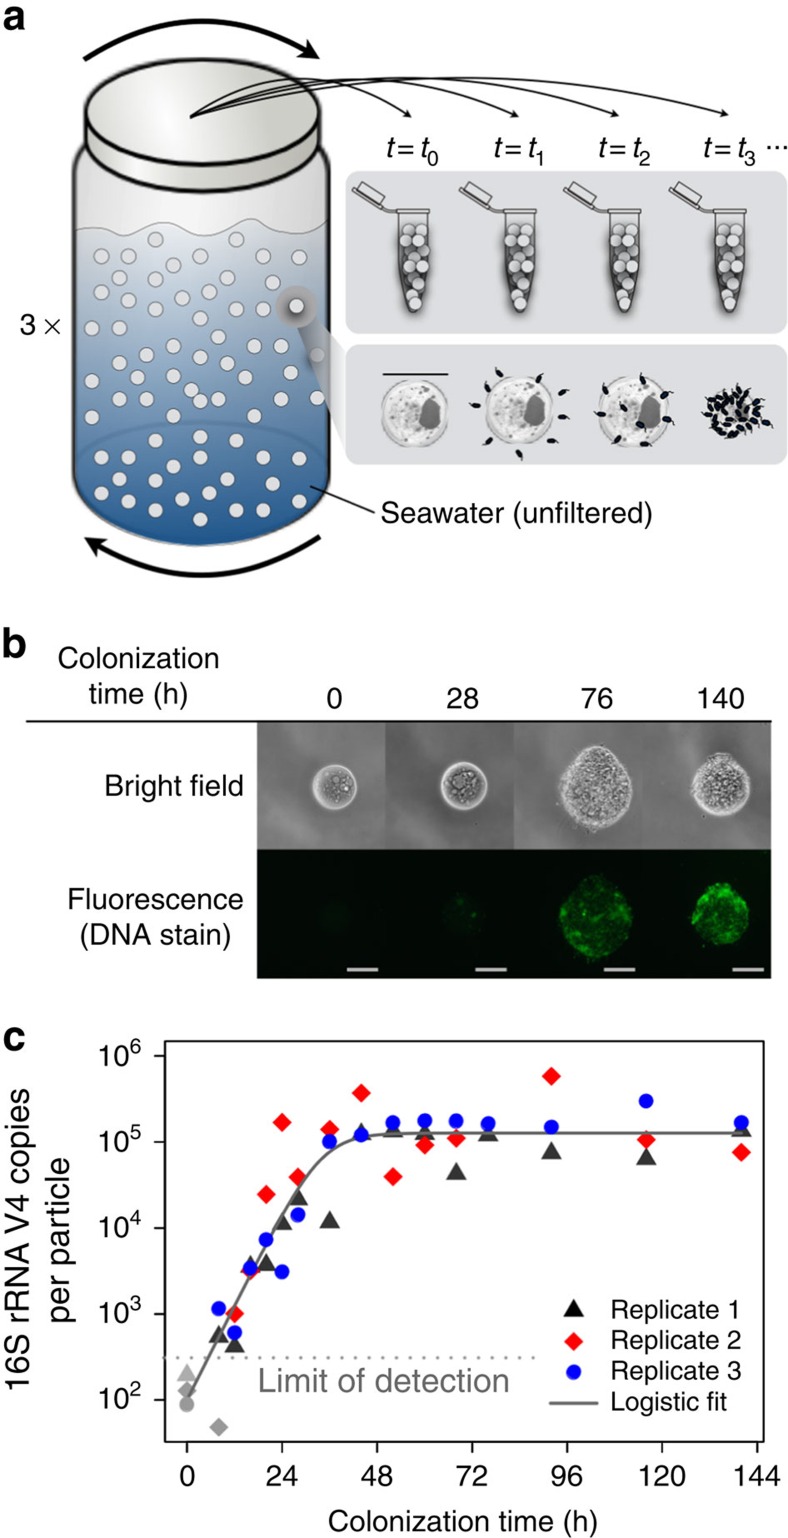
Marine bacteria form communities on model particles.(a) Schematic of particle colonization procedure. (b) Particle-attached communities stained with SYBR Green I, a double-stranded DNA strain, and imaged with bright field (top) and fluorescence (bottom) microscopy (Supplementary Methods). Scale bars, 25 μm. Note that different particles are depicted for each time point. (c) Total 16S rRNA V4 copies per particle over time for three colonization replicates (, , ). Symbols in grey (, , ) indicate measurements below the limit of detection of the assay. The grey line (-) indicates the fit to a logistic growth model.